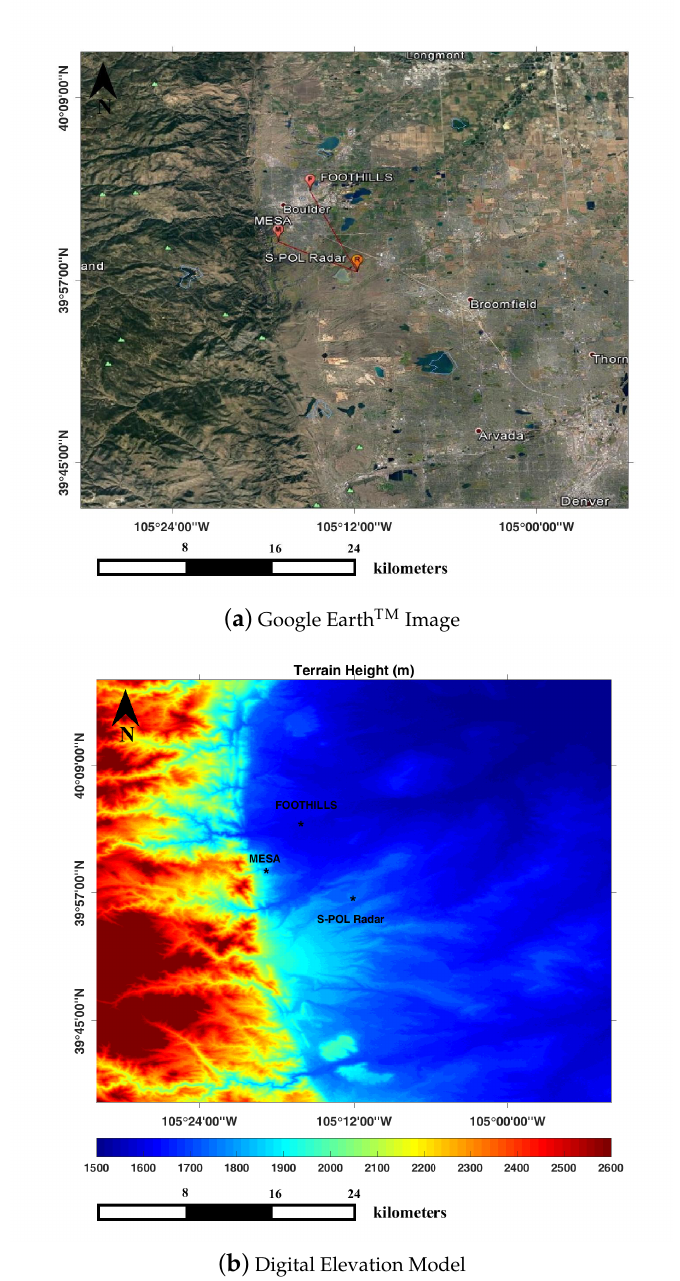
Figure 1. Location of the study area at the base of the Rocky Mountains in Boulder (Northeast Colorado, USA): ( a ) Google Earth TM image showing the location of the radar and the automatic weather stations; ( b ) topographic map of the terrain (National Elevation Dataset of the U. S. Geological Survey